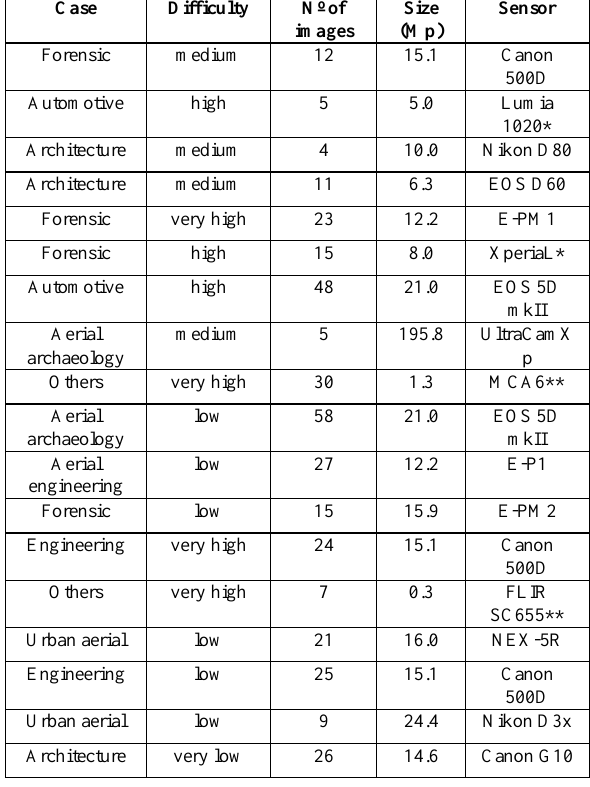
Table 1. Information about some cases studies, including information on the level of difficulty (from a geometric and/or radiometric point of view)